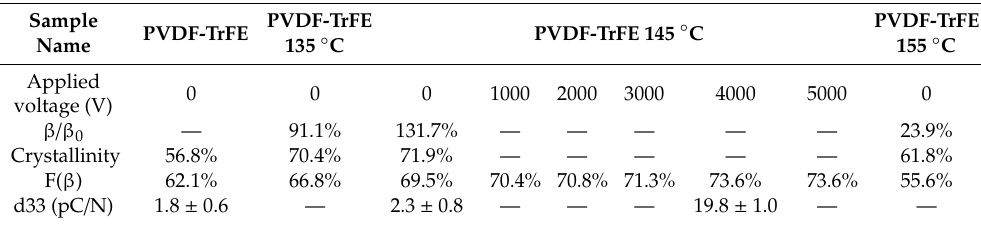
Table 1. Measurement results of the crystallinity, β -phase percentage, and piezoelectric coe ffi cient of PVDF-TrEE after di ff erent annealing and polarization